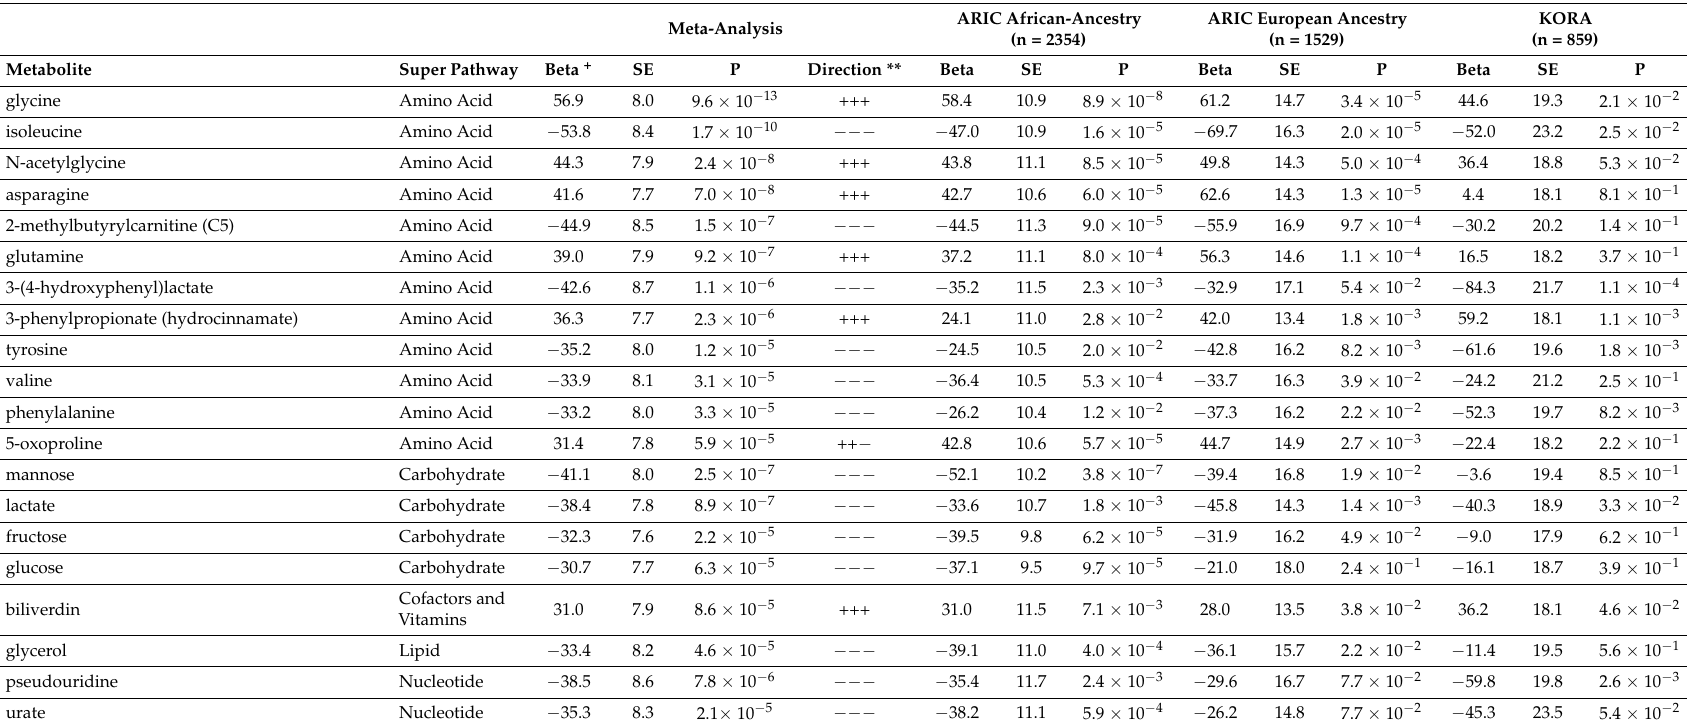
Table 3. Top 20 metabolites associated with FVC at Bonferroni significance ( p < 1.4 × 10 − 4 ) in meta-analysis